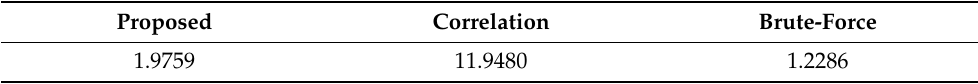
Table 2. Average position errors (in pixels) of the entire Figure 5